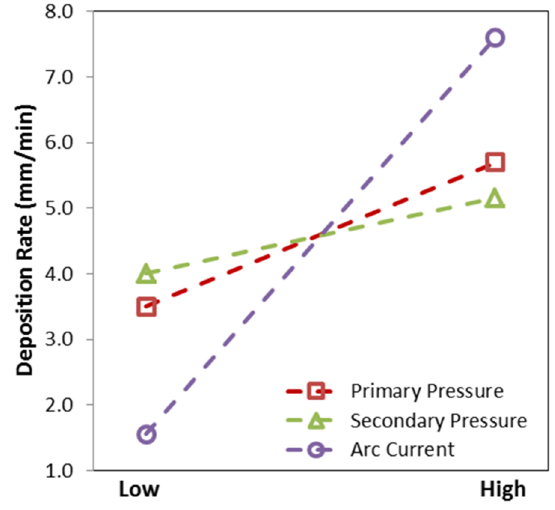
Figure 8. Effect of primary gas pressure, secondary gas pressure, and arc current on coating deposition rate. Note: dashed lines not meant to imply a linear